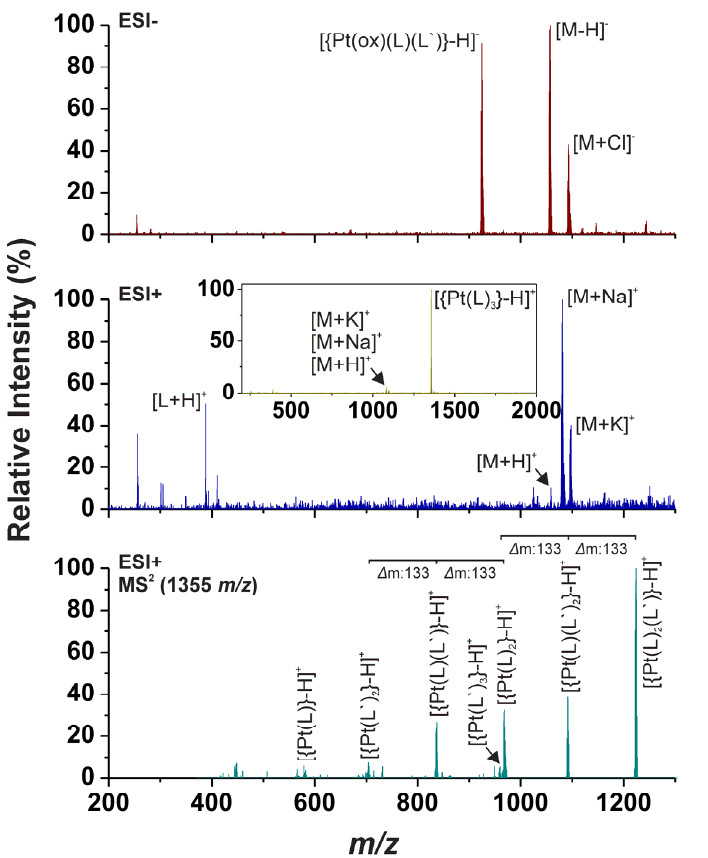
Figure 2. The results of mass spectrometry of 1 as obtained in the negative (ESI-; up ) and positive (ESI+; middle ; inset : spectrum obtained in the 200–2,000 m/z range) mode within }–H] + peak observed at 1,355 m/z the 200–1,300 m/z range. The MS 2 spectrum of the [{Pt(L) 3 showing the fragmentation of the species through the ribose moiety elimination ( down